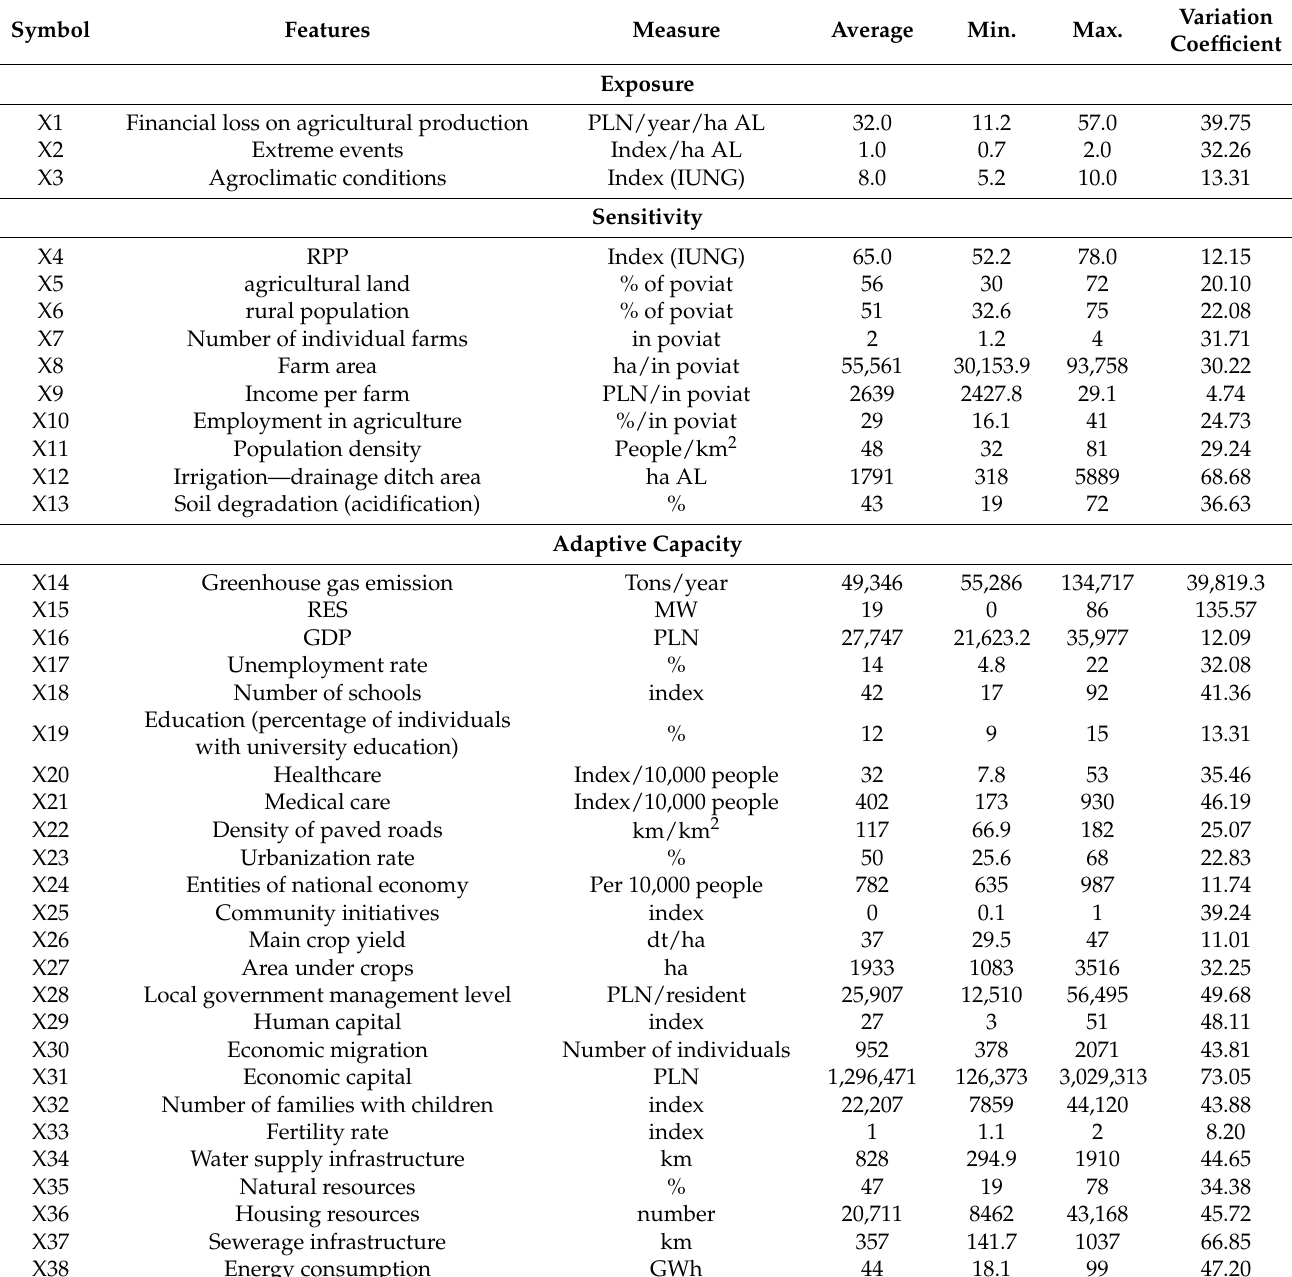
Table 2. A list of indices was taken into account in the VCC study with the main descriptive